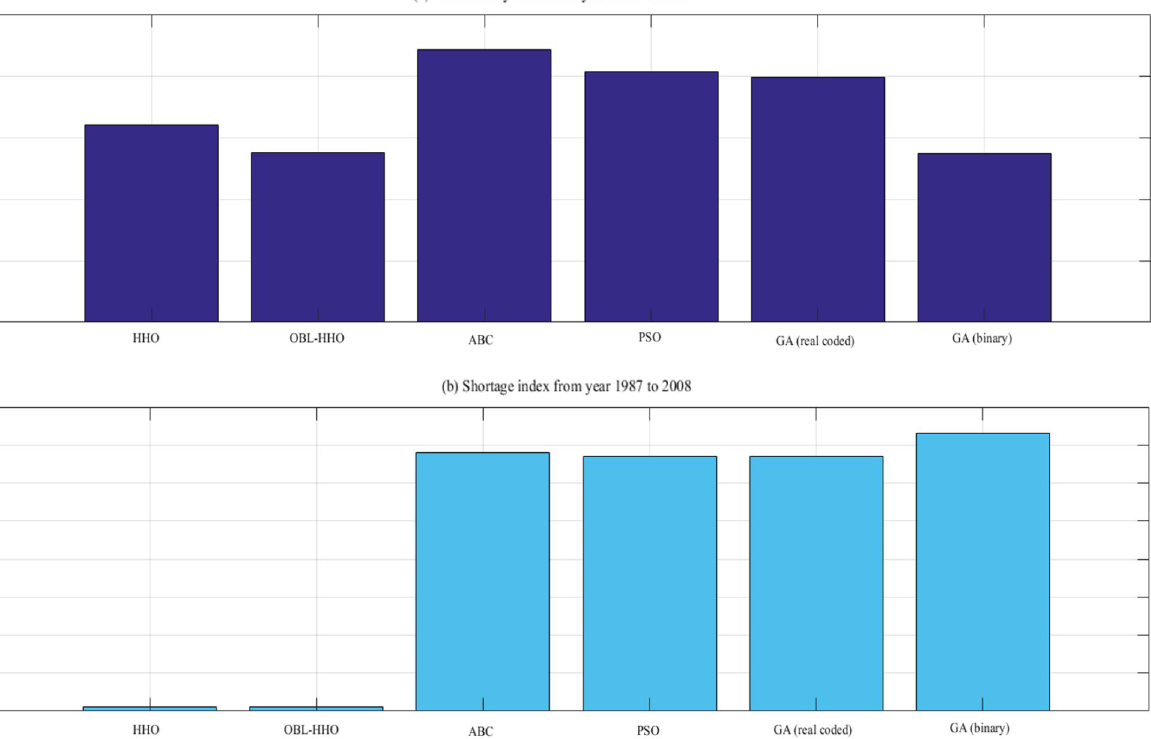
Figure 9. ( a ) Vulnerability index and ( b ) shortage index from year 1987 to